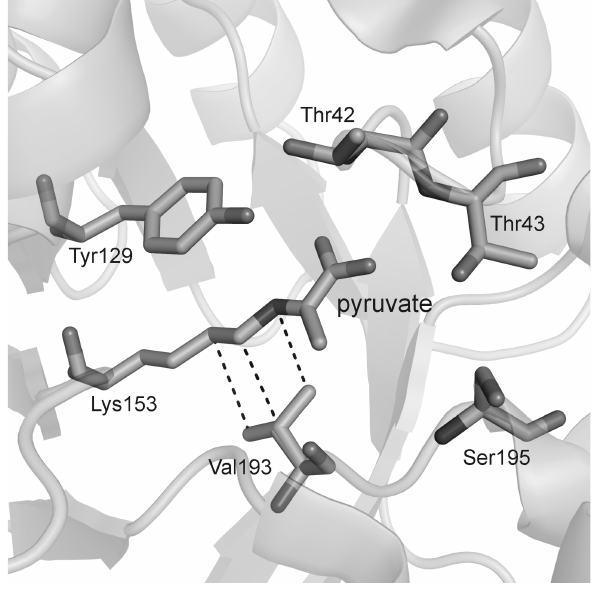
Figure 2. Diagram of the active site of SacKdgA with pyruvate cova- lently bound to Lys153 (pdb: 2nuy). Van der Waals interactions be- tween the Lys153 side chain and Val193 are indicated with dotted lines. The figure was generated with PyMol.